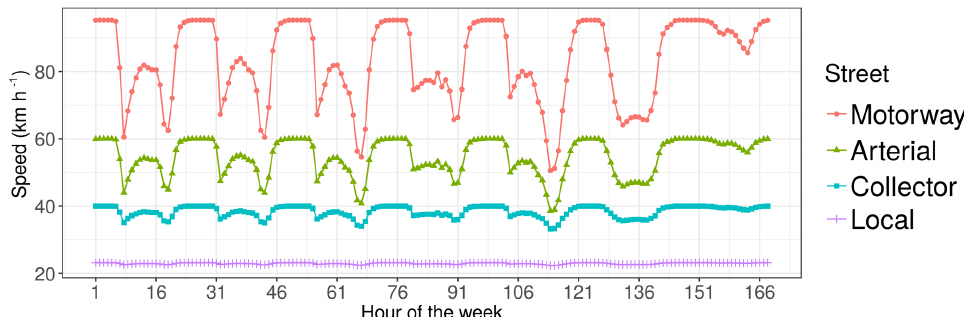
Figure 4. Traffic average speeds for LDV fleet by type of street (colored lines) at 08:00–09:00LT in MASP.